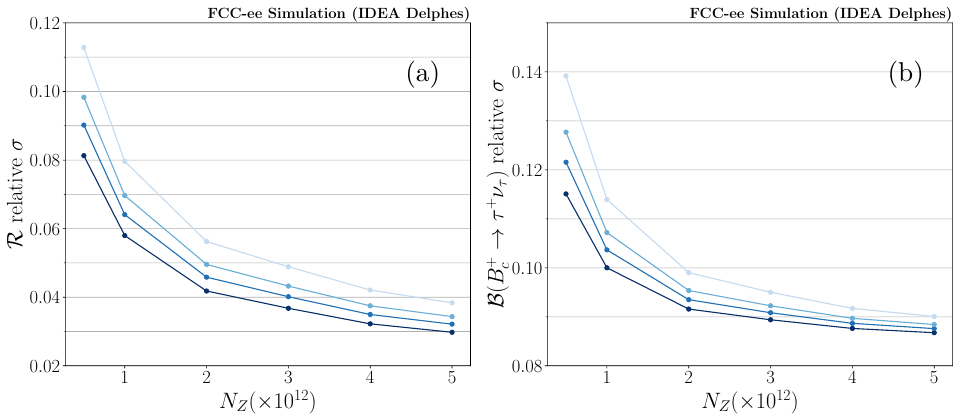
Figure 8 . (a) Relative precision on the ratio of branching fractions R = B ( B + → τ + ν τ ) / B ( B + → c c J/ψµ + ν µ ) as a function of N Z . (b) Relative precision on B ( B + → τ + ν τ ) as a function of N Z , using c a SM prediction for B ( B + → J/ψµ + ν µ ) . The different shades of blue correspond to different levels c of systematic uncertainty on N ( B + → τ + ν τ ) relative to the statistical uncertainty, following the c same colour scheme as figure